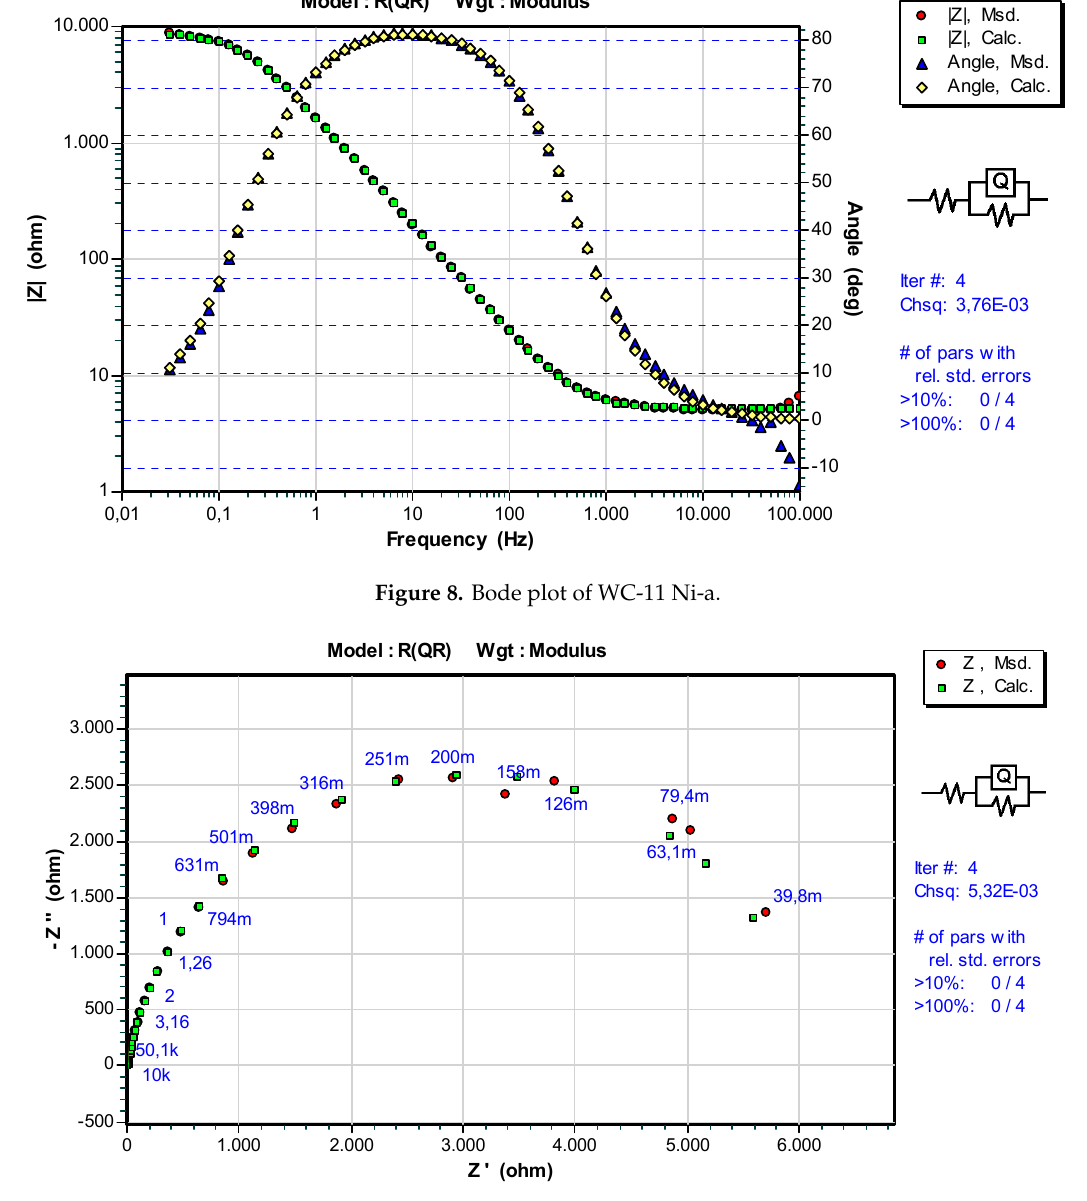
Figure 9. Nyquist plot of WC-11 Co-c.